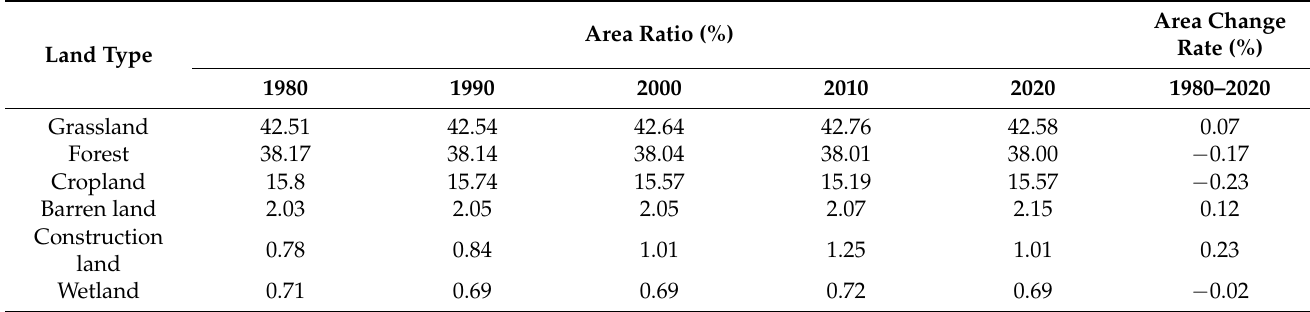
Table 6. Changes of land use types in different periods in the Yangtze River basin.